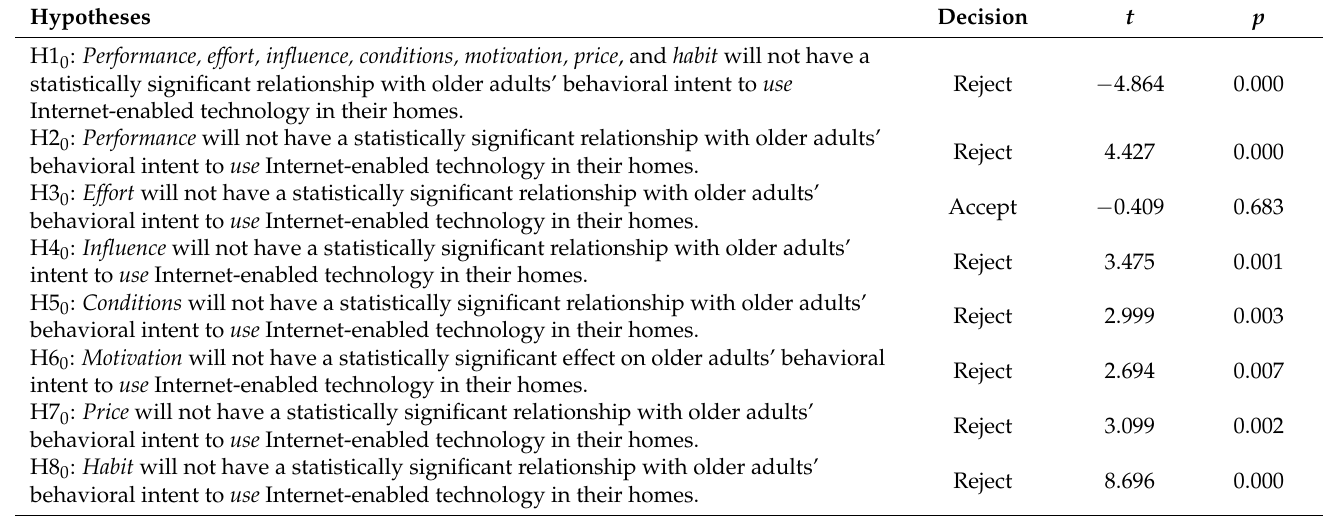
Table 10. Statistical significance summary of null